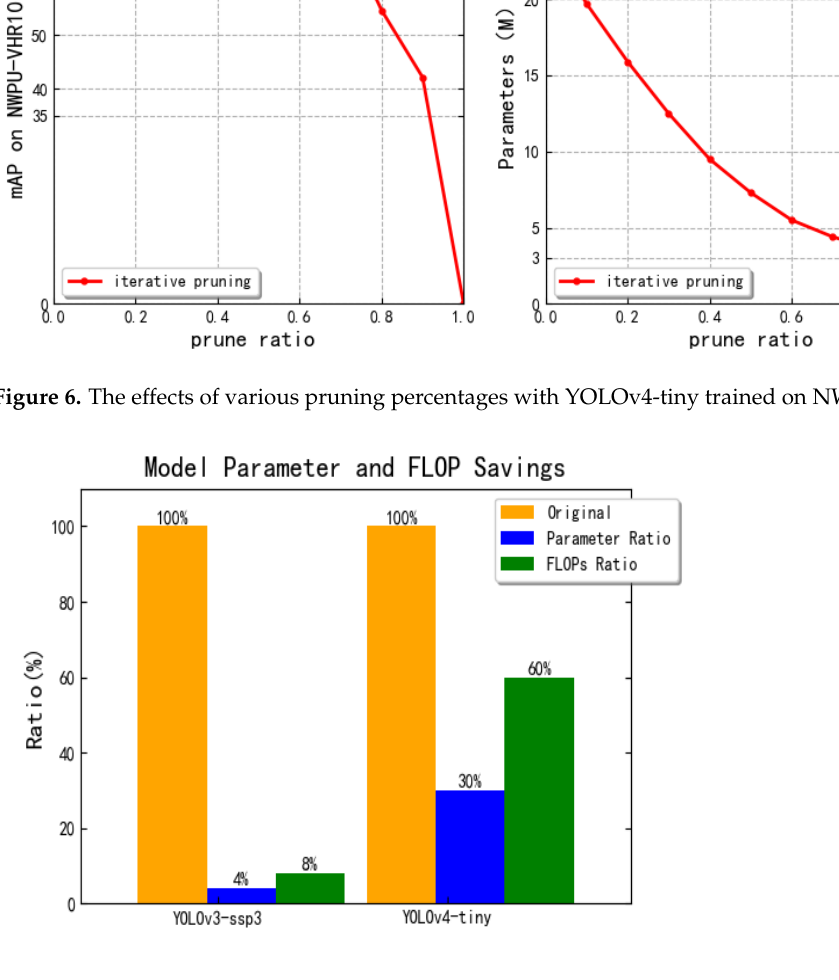
Figure 7. Comparison of the pruned models and the original models on NWPU VHR-10. The blue and green bars are the parameter and FLOPs ratios between the pruned and original